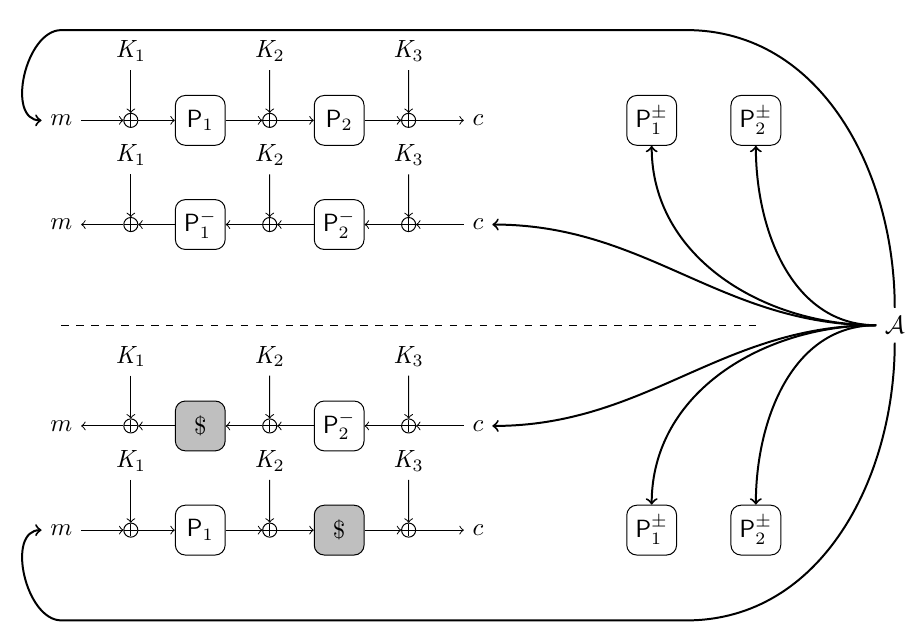
Figure 2: KDM-CCA analysis for 2-round